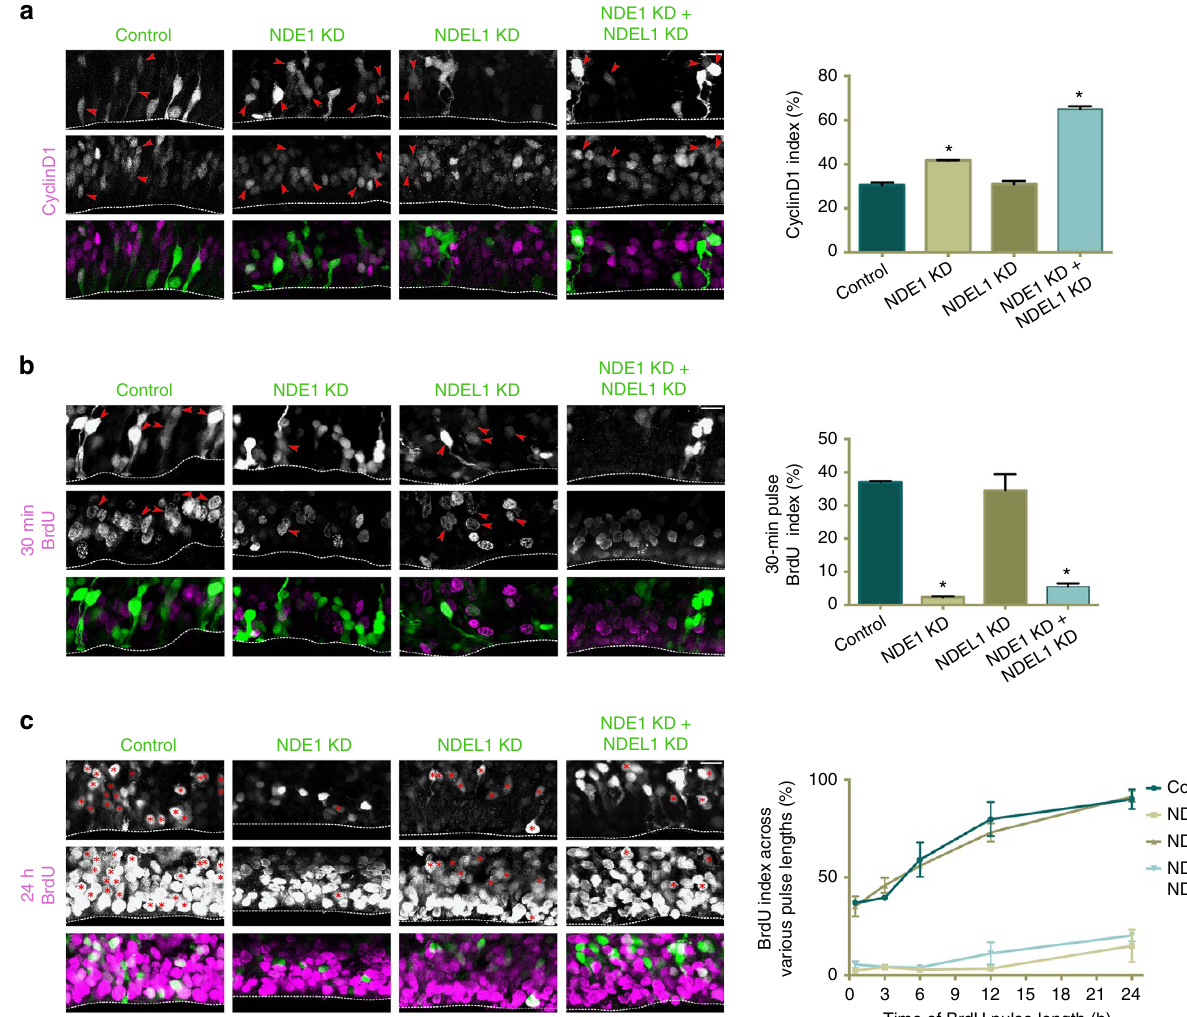
Figure 3 | Double knockdown of NDE1/NDEL1 arrests cells at the G1-to-S transition. E16 rat embryonic brains were electroporated with shRNAs for the various conditions and examined at E19. CyclinD1 staining was used to mark G1 cells, a 30min pulse of BrdU used to mark S-phase cells, and BrdU pulses of varying length were used to distinguish RGPs that are arrested during the cell cycle from those actively cycling. The CyclinD1 and BrdU indices used in quantification were calculated as the amount of electroporated radial glia progenitors (RGPs) positive for either marker divided by the total number of electroporated RGP cells. ( a ) NDE1 knockdown caused a small but significant increase in CyclinD1-positive RGP cells, and the NDE1/NDEL1 double knockdown caused an even more substantial doubling of CyclinD1-positive RGP cells. There was no apparent difference between NDEL1 knockdown and control conditions. CylinD1-positive RGP cells tended to have soma located further away from the ventricular surface. Arrowheads mark electroporated RGP nuclei positive for CyclinD1. ( b ) NDE1 and NDE1/NDEL1 double knockdown caused a reciprocal and severe decrease in BrdU-labelled RGP cells. Again there was no significant difference between NDEL1 knockdown and control conditions. Arrowheads mark electroporated RGP nuclei positive for BrdU. ( c ) BrdU pulses of varying length revealed an increase in BrdU incorporation among control RGPs and NDEL1 knockdown RGPs, in contrast to the very minimal increase in BrdU incorporation over 24h in the NDE1 and NDE1/NDEL1 knockdown conditions. Unpaired t -tests comparing knockdown conditions at each hour revealed no significant difference between control and NDEL1 knockdown, or NDE1 and NDE1/NDEL1 knockdown, while those two pairings were significantly different at every time point observed. Asterisks mark electroporated RGP cells positive for BrdU. Data are presented as mean ± s.e.m. Unpaired t -tests used to compare conditions, * P o 0.05, n ¼ 3 embryonic brains from different mothers. Scale bar, 10 m m in a – c . See Supplementary Figs 2 and 3 for further information regarding proliferation status cell cycle of knockdown RGP cells. Dashed line indicates ventricle